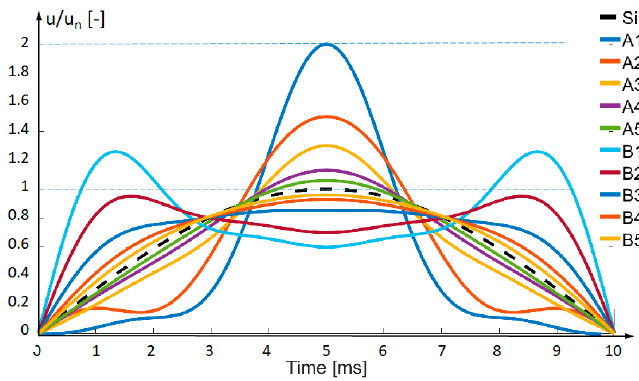
Figure 3. Supply voltage signal power amplifier. Table 3. Input signals parameters (harmonic’s amplitudes and phases).